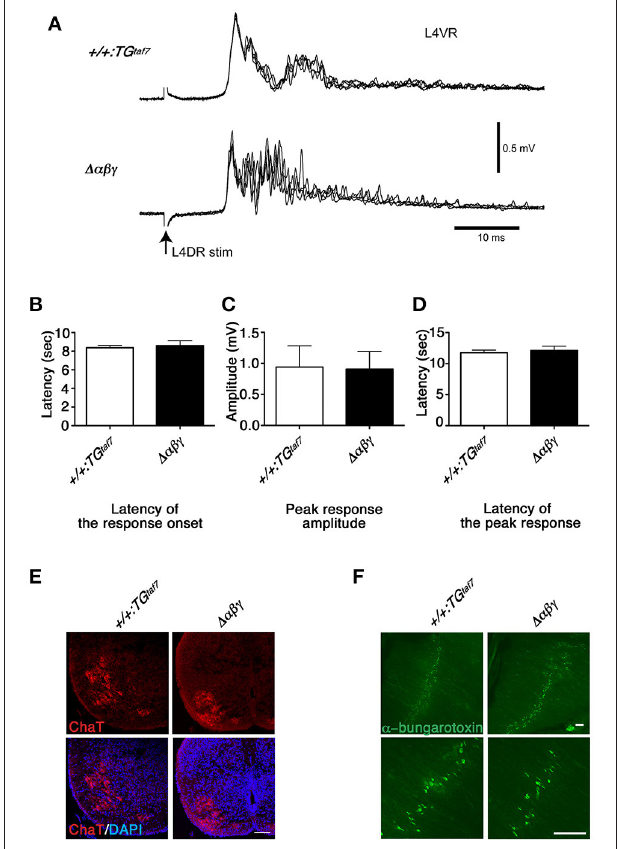
FIGURE 3 | Normal monosynaptic but abnormal polysynaptic stretch-reflex circuits. (A) Spinal reflex at E18.5. Electric stimuli to L4DR normally activate Ia afferents and elicit an action potential in motor neurons. Monosynaptic reflex circuits appeared normal, but the polysynaptic reflex circuits were disrupted in the ∆αβγ mutant. No differences were detected in the latency of the response onset (B) , the peak response amplitude (C) , or the latency of the peak response (D) . Error bars represent SEM; data were compared by Student’s t -test. (E) ChAT staining of the E18.5 ∆αβγ spinal cord. The number of neurons and the size and distribution of motor neurons were indistinguishable between genotypes. (F) Whole-mounted E18.5 diaphragm muscles were stained with FITC-conjugated α -bungarotoxin, which binds specifically to acetylcholine receptors (AChRs). As in the control ( + / + :TG taf 7 ) mice, AChR clusters were aligned normally in the central region of the muscles of the mutant mice. Bars: 100 µ